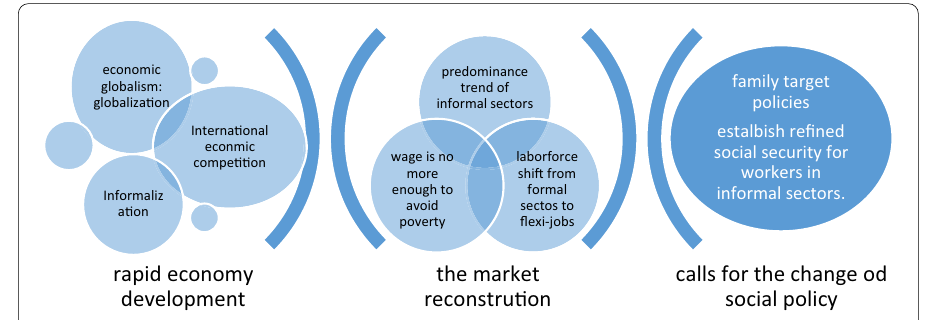
Fig. 4 Relationships among work, labour market and social